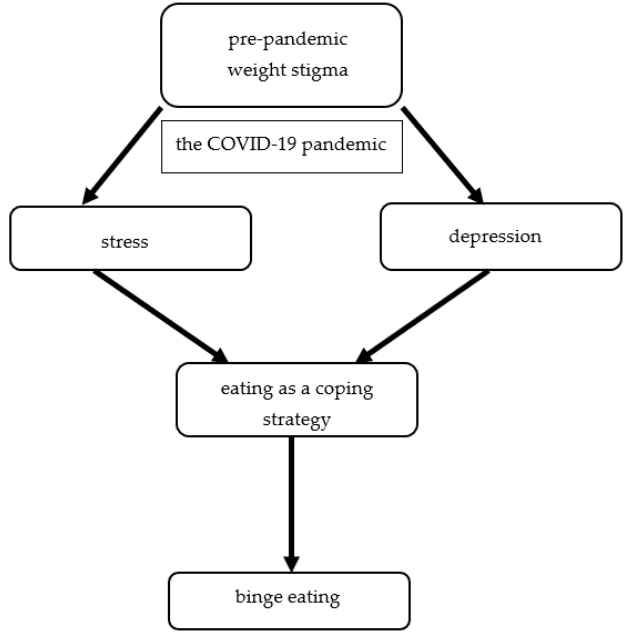
Figure 4. The risk factor of binge eating development during the COVID-19 pandemic in young adults with obesity.